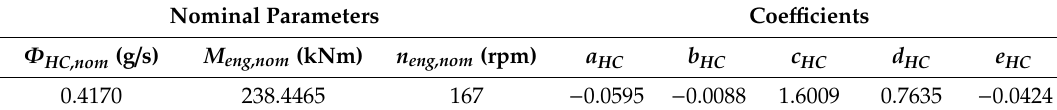
Table A2. Coe ffi cients of HC emission model of main engine.